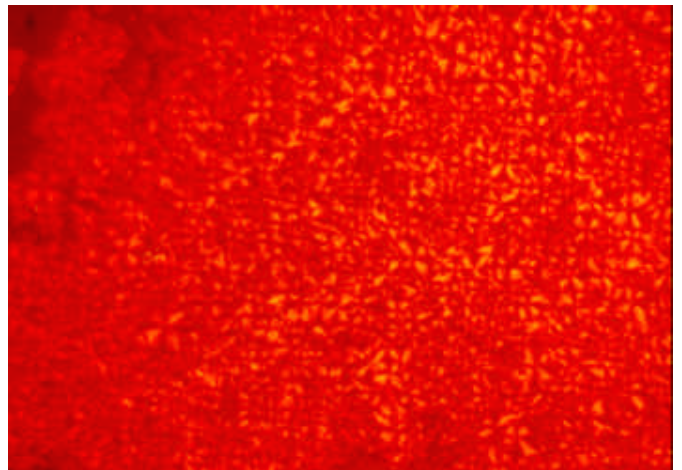
Figure 2a. Finger-like texture of compound IIIb -12Co near to phase transition - a mesophase - iso- tropic liquid, 219°C, crossed polarization, magnification